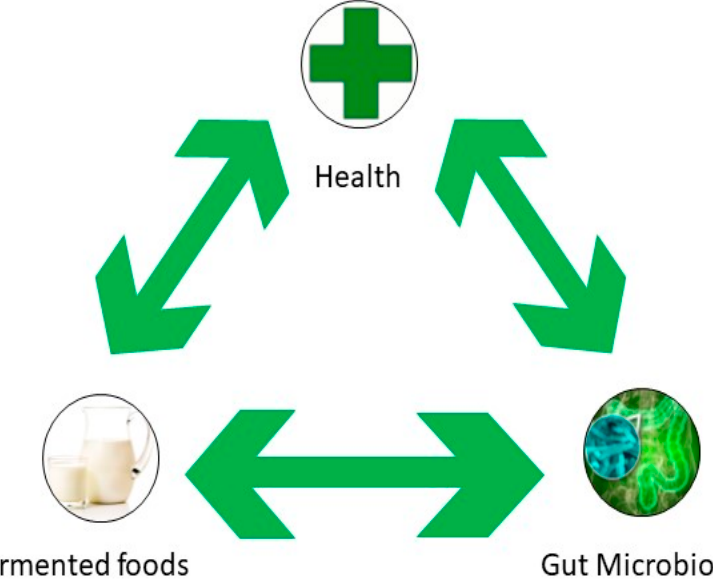
Figure 1. Relationship between fermented foods, gut microbiota, and impact on the human health.